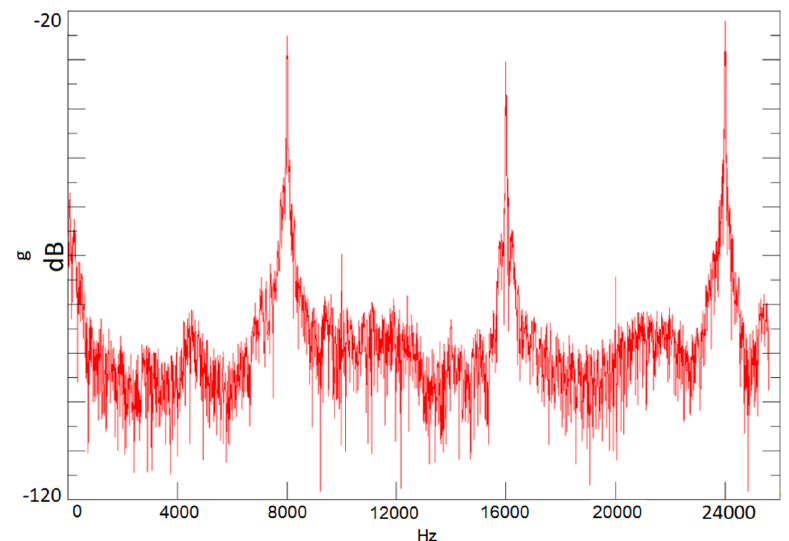
Figure 15. FFT of vibration signal at 8 kHz switching frequency—dB scale.